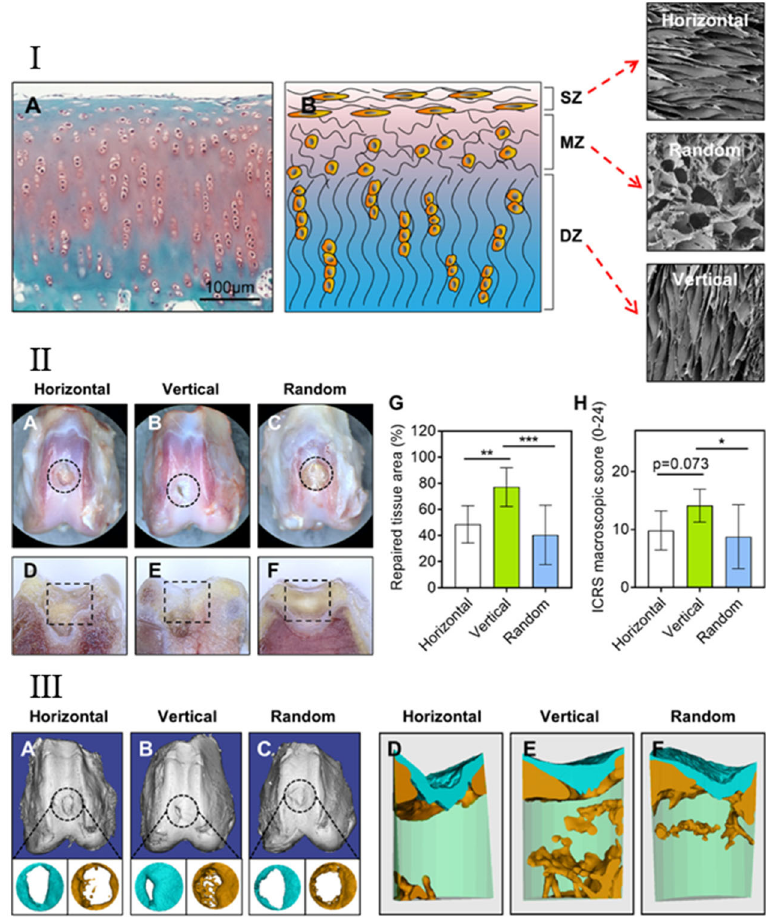
Figure 4. ( I ). Schematic illustration of the ECM structure of cartilage. The ECM of cartilage is divided into three layers, as follows: the horizontally aligned, randomly arranged, and vertically aligned from the superficial layer to the deep layer. Abbreviations are as follows: SZ, surface zone; MZ, middle zone; DZ, deep zone. ( II ). The horizontal, vertical, and random scaffolds fabricated using controlled directional freeze ‐ drying were implanted into the rabbit osteochondral defect model, and the repair efficacy was evaluated after 12 weeks. There was a lot of cartilage neotissue on the surface of the vertically arranged scaffold as well as in the repaired tissue area, and the average ICRS mac ‐ roscopic scores were higher than those of the other two groups (* P <0.05 , ** P <0.01 , *** P <0.001). ( III ). Evaluation by micro ‐ CT and 3D reconstruction. The vertically aligned scaffold group showed superior cartilage and subchondral bone repair (Reproduced from [196], American Chemical Soci ‐ ety).